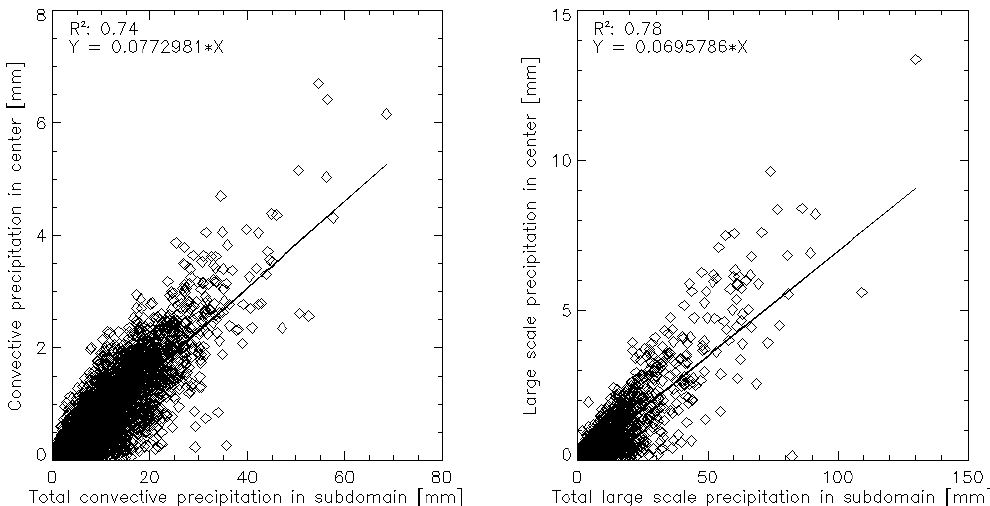
Figure 6. Statistical relations established between GCM and ERA-Interim precipitation, for convective-only precipitation ( left ) and large-scale precipitation ( right ).